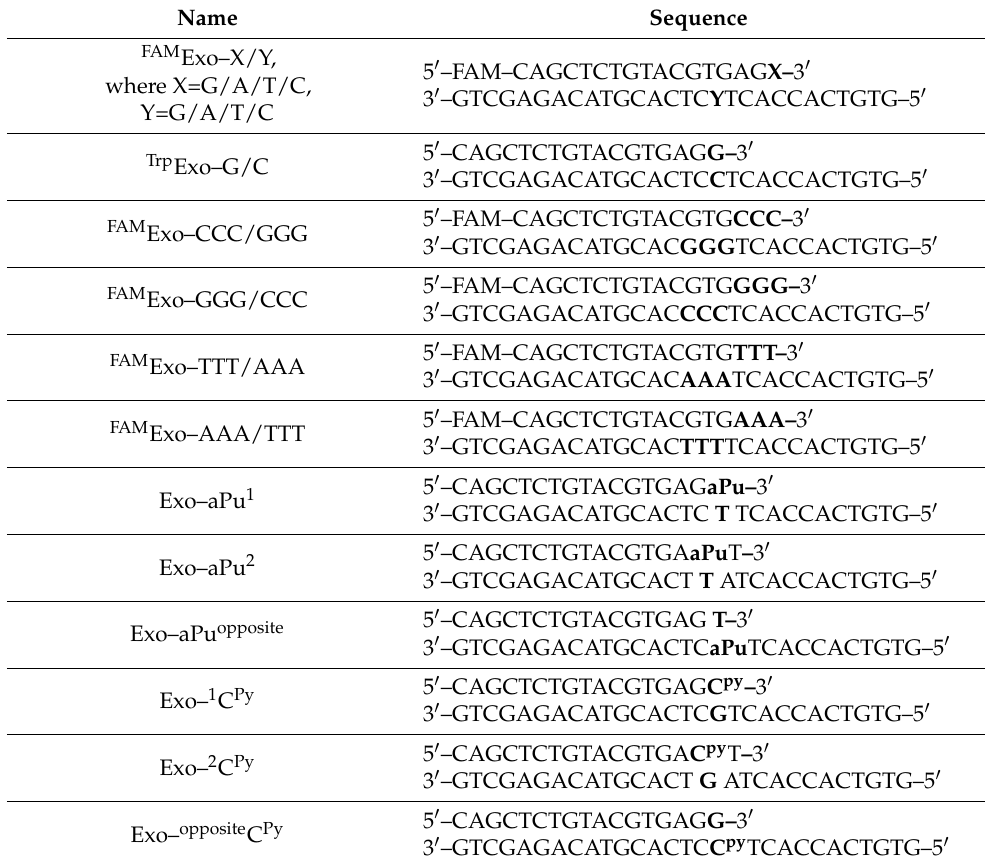
Table 2. DNA duplexes used as